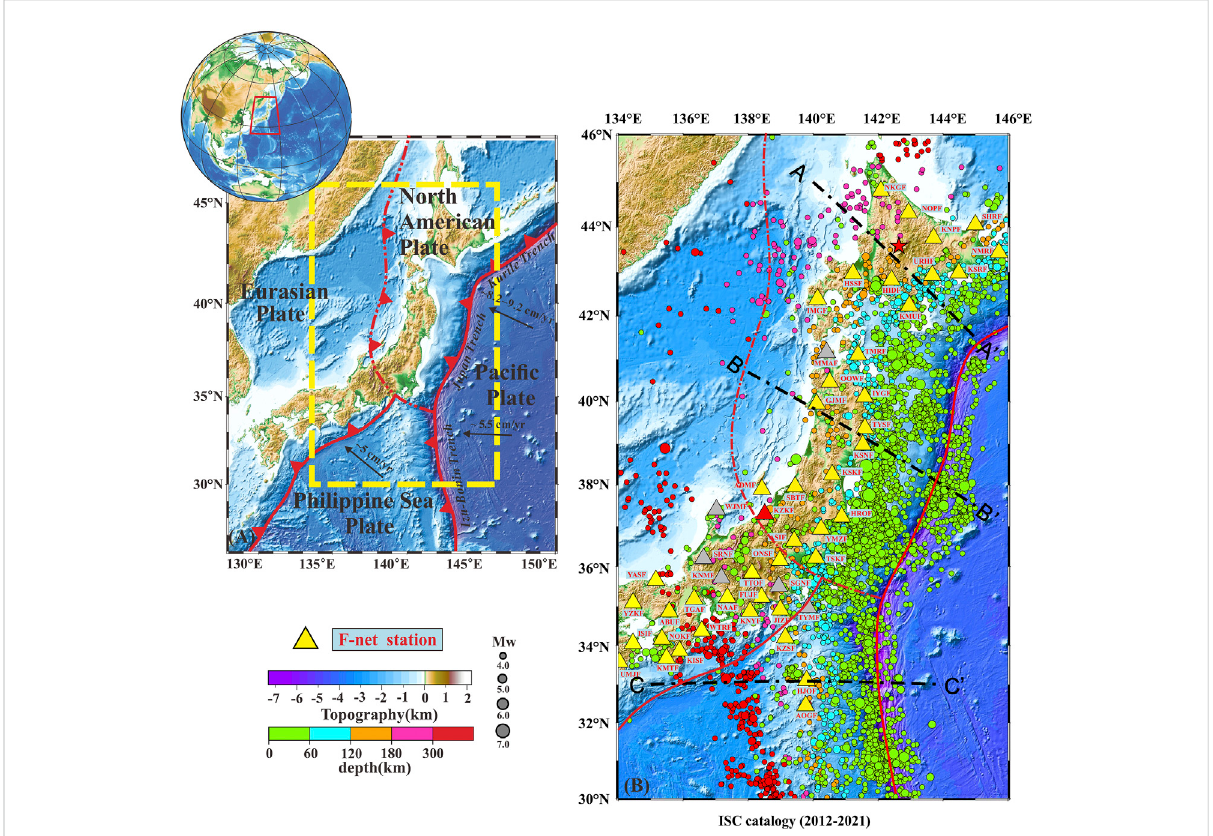
FIGURE 1 (A) Topography of the Northwestern Paci fi c Ocean; The black arrows show an estimate of the motion (cm/year) of the Paci fi c Plate relative to theNorth American Plate andPhilippineSea Plate. The red solid(dash) line and represents theboundary(presumedboundary) of theplates, with red triangles on it indicating the direction of movement of the plates. The names of the three trenches are described in orange italic letters. (B) The seismicity with the Mw ≥ 4.0 of the study area (2012 – 2021). The seismicity from the ISC catalogue is denoted by the dots. The depth and magnitude of earthquakes are shown by the color bar and sizes of the dots, respectively. The location of the study area is denoted by the yellow box in (A) . The black solid lines illustrate the trench-normal pro fi les (LINE A-A ’ , B-B ’ , and C-C ’ ). The triangles represent the stations of F-NET. The yellow onesrepresentthestationsusedformomenttensorinversioninthispaper,whiletheotherstationsofF-NETareingrey.Theredstarinthenortheast of the fi gure represents the location of a reverse faulting event as an example of earthquake waveform fi tting using the Mttime